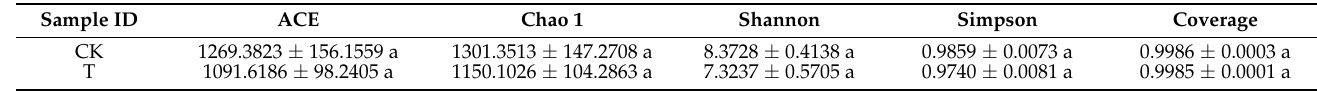
Figure 3. Rarefaction curve and Shannon index rarefaction curve of Grapholita molesta gut micro- biota samples before and after ciprofloxacin feeding. ( A ) Rarefaction curve; ( B ) Shannon index rarefaction curve. Table 3. Statistical analysis of α diversity index of Grapholita molesta gut microbiota before and after ciprofloxacin